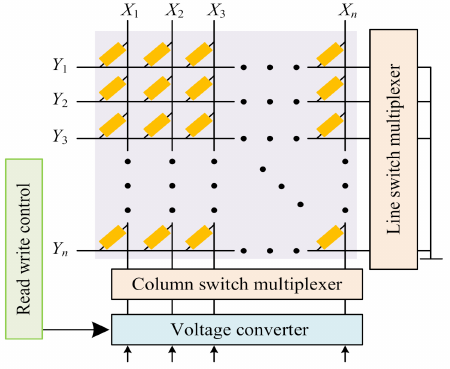
Figure 9. Image interpolation based on memristive system.